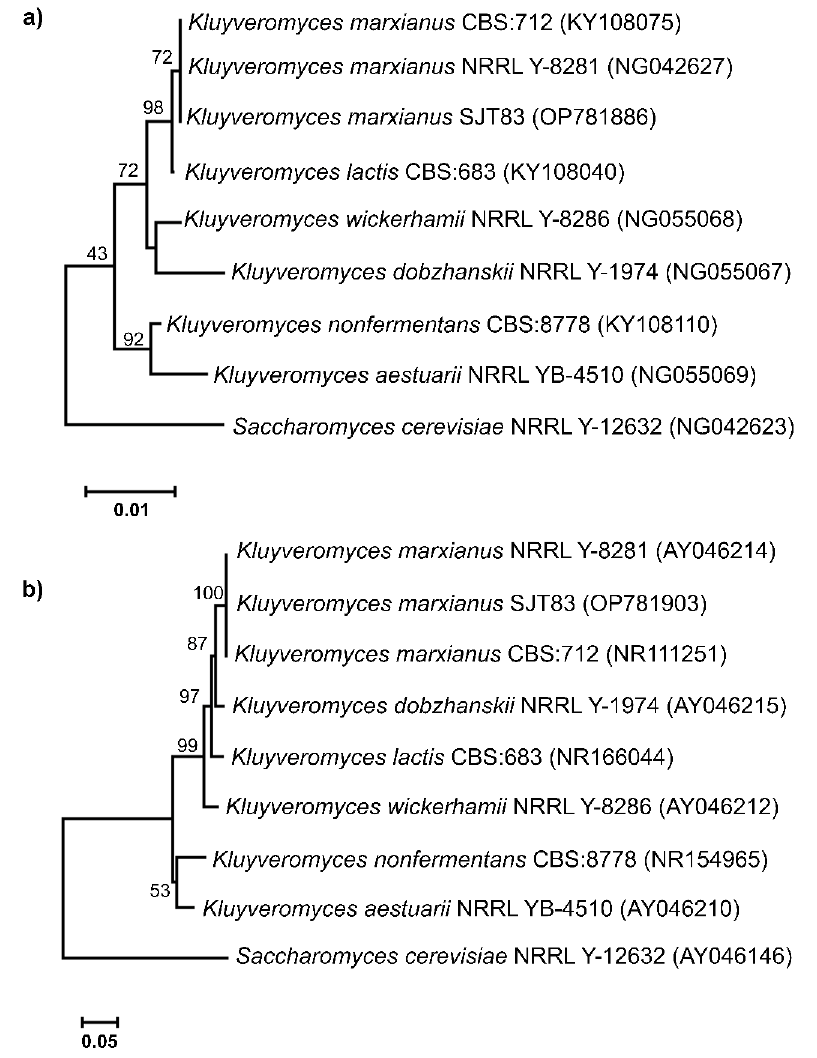
Figure 3. Phylogenetic tree resulting from analysis of D1/D2 domain of 26S rDNA gene ( a ) and ITS gene ( b ) of K. marxianus SJT83. gene ( b ) of K. marxianus